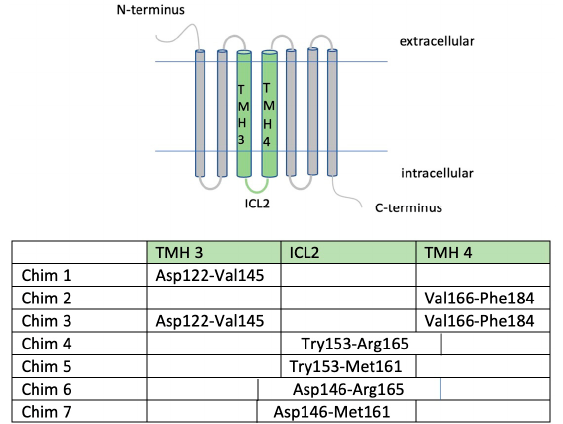
Figure 1. Arrangement of MC4R/CB1R chimeric constructs. The table illustrates amino acid se- quences and regions interchanged with the CB1R via overlap PCR. Chimera specification: Chim